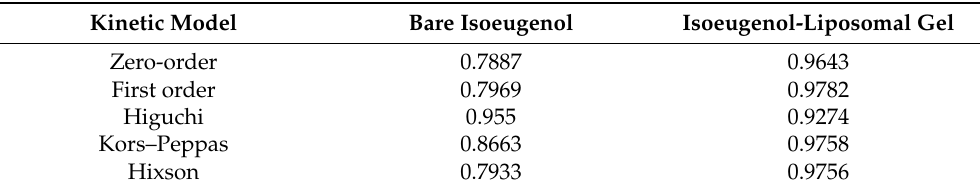
Table 1. r 2 value of bare isoeugenol and isoeugenol-liposomal gel using different kinetic studies for 24 h. Date presented is taken from in vitro drug release study.